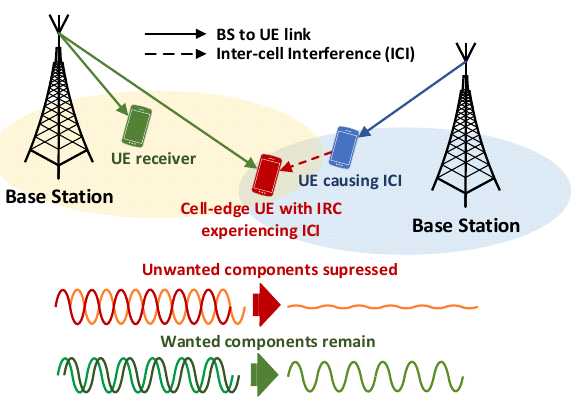
Figure 1. The interference rejection combining (IRC) concept to suppress intercell interference (ICI).